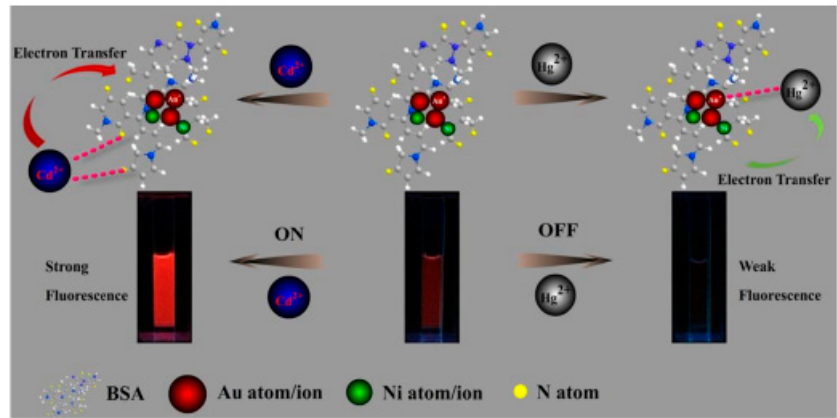
Figure 15. Schematic diagram of the mechanism of the detection of Cd 2+ and Hg 2+ ions by the fluorescent BSA-Au-Ni NCs (Copyright Ref [180], Springer publications).